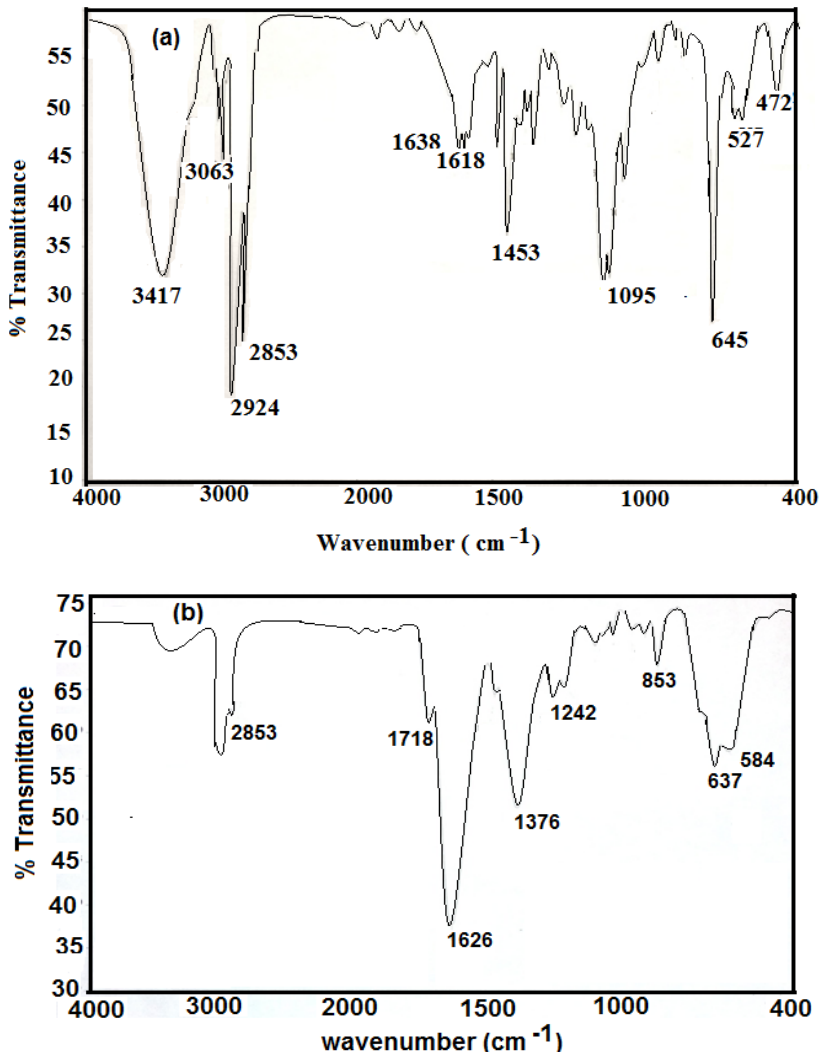
Figure 1. FTIR specta of ( a ) oleic acid coated magnetite and ( b ) PAMPS-Na-co-St/magnetite